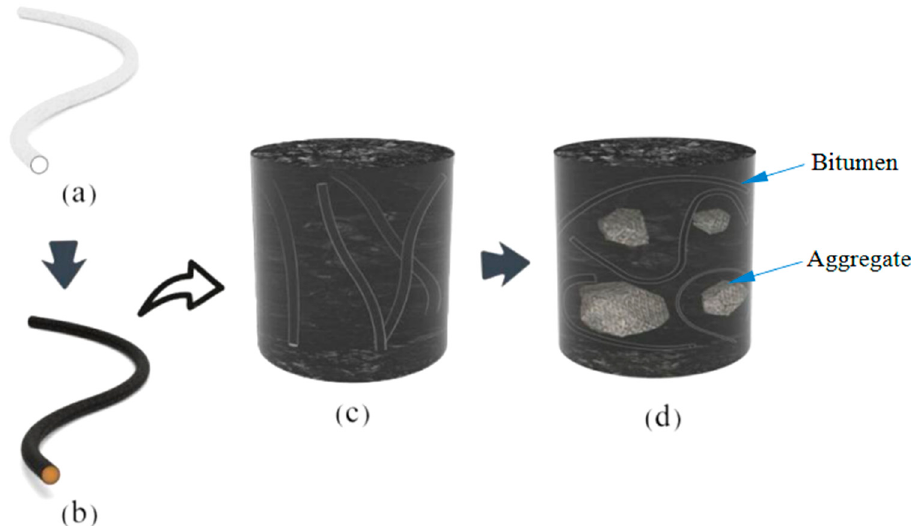
Figure 1. Illustration of the self-healing mechanism of asphalt using a microvascular containing oily rejuvenator, ( a ) a microvascular without rejuvenator, ( b ) a microvascular containing oily rejuvenator, ( c ) a microvascular with rejuvenator in pure bitumen, ( d ) a microvascular with rejuvenator in asphalt mixture.